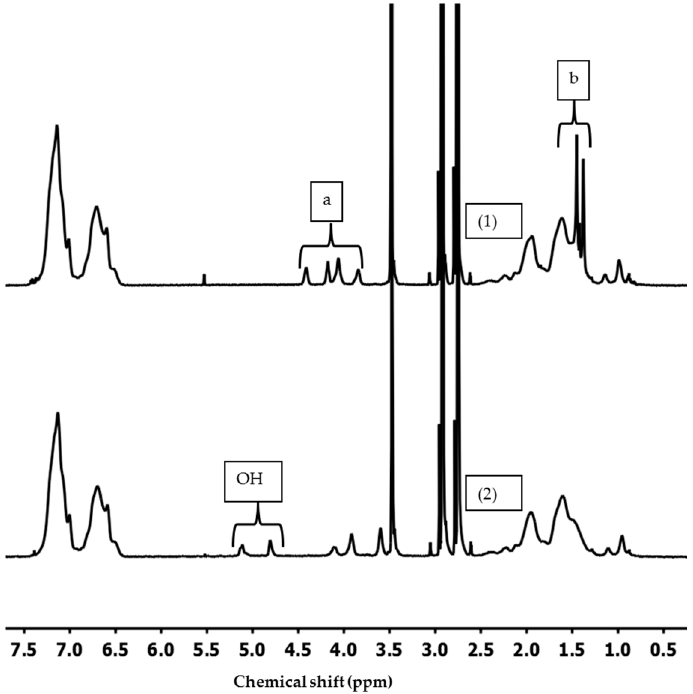
Figure 2. 1 H NMR spectra depicting the difference between the polymeric chains of PS 81 -PSMA 19170 (1) and PS 85 - b -PGMA 15158 (2) in DMF- d7.